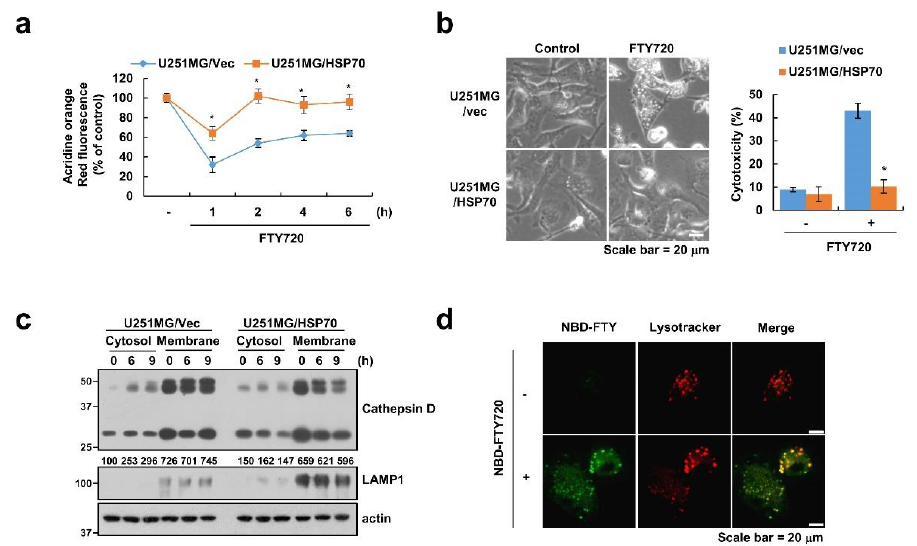
Figure 5. Ectopic expression of HSP70 inhibits FTY720-induced LMP. ( a – c ) U251MG/vector and U251MG/HSP70 cells were treated with 10 μM FTY720 for the indicated time periods. Cells were stained with lysotracker red ( a ). Cell morphology was examined using interference light microscopy. Cell cytotoxicity was detected by LDH assay ( b ). Cytosol and membrane fractions (lysosome-rich fraction) were prepared, and the protein levels were determined by Western blotting. LAMP1 is shown as cell compartment controls (lysosome-rich membrane fraction) ( c ). ( d ) U251MG cells were treated with 10 μM NBD-FTY720 for 6 h, and then cell morphology was detected by confocal microscopy. The mean number of microscopic images ( b , d ) per sample is 10, and these images were taken randomly. The values in the graphs ( a , b ) represent the mean ± SD of three independent experiments. * p < 0.01 compared to the FTY720-treated U251MG/vector.